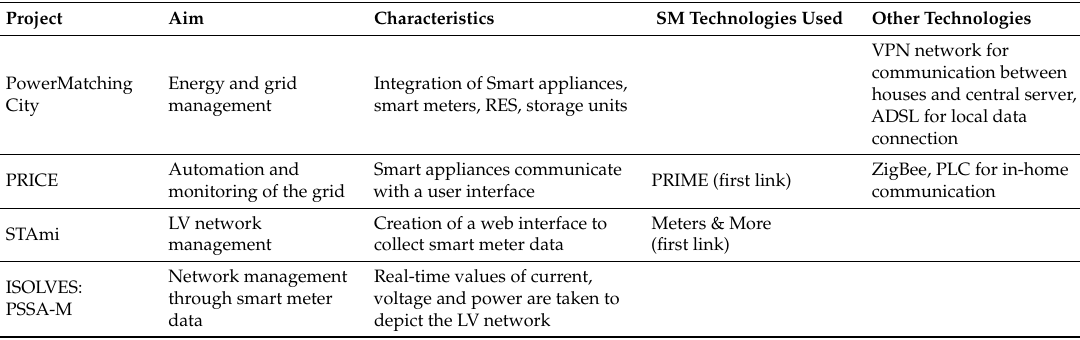
Table 7. Summary of projects for Grid